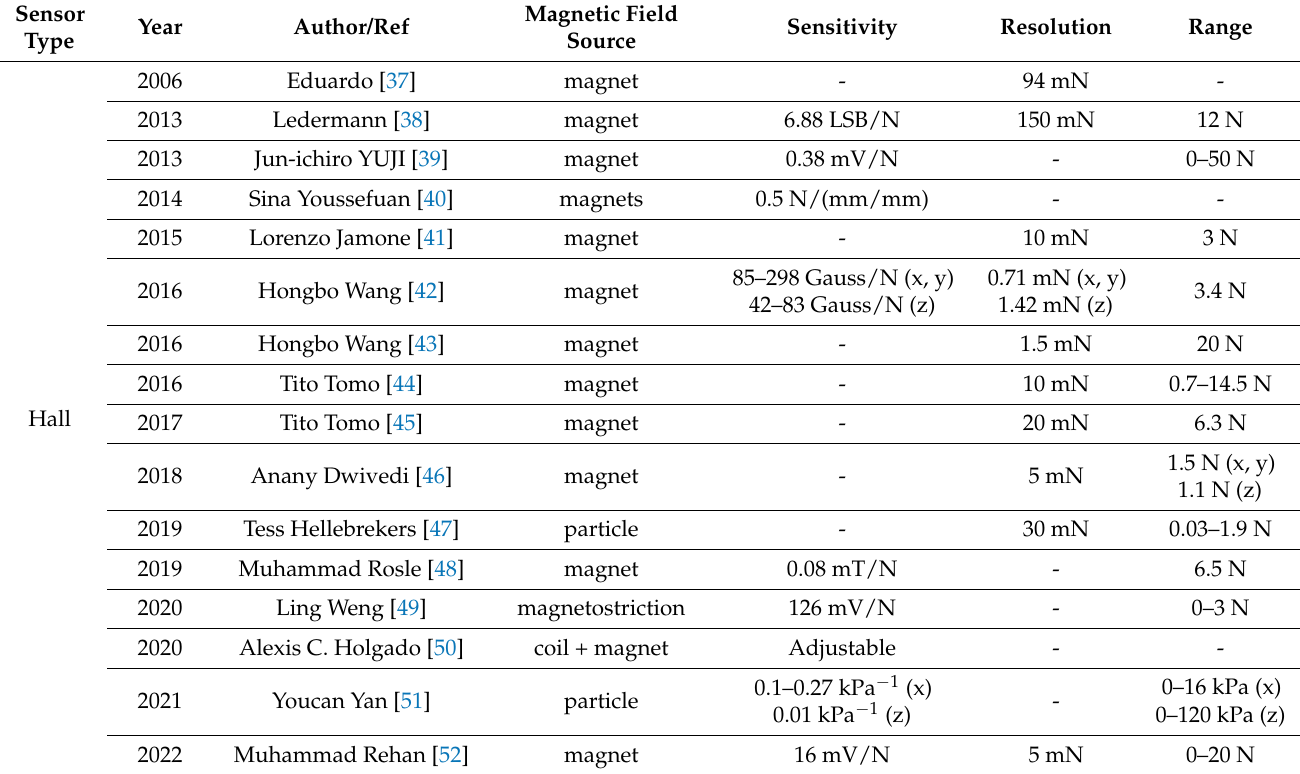
Table 1. Comparison of magnetic tactile sensors of different